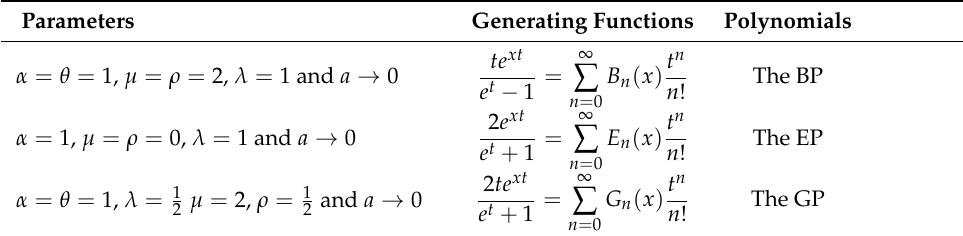
Table 3. Parameters for the classical polynomials.